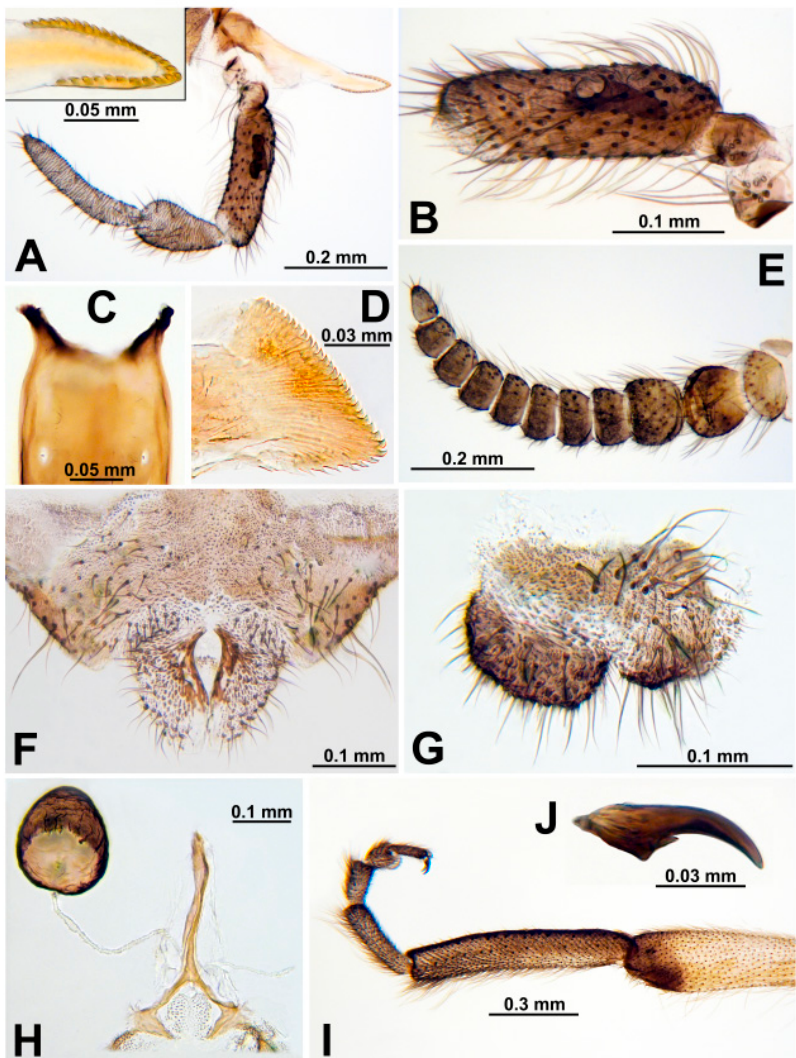
Figure 4. Female of Prosimulium supernum n. sp. ( A ) Maxillary palp with 5 palpomeres and lacinia; inset shows apex of lacinia. ( B ) Maxillary palpomeres I, II, and III, showing sensory vesicle. ( C ) Cibarium, anterior. ( D ) Mandible, apex. ( E ) Antenna. ( F ) Sternite VIII and hypogynial valves. ( G ) Anal lobe and cercus, lateral view. ( H ) Genital fork and spermatheca. ( I ) Hind tibia (apical portion only), tarsus, and acropod with claws. ( J ) Hind claw.